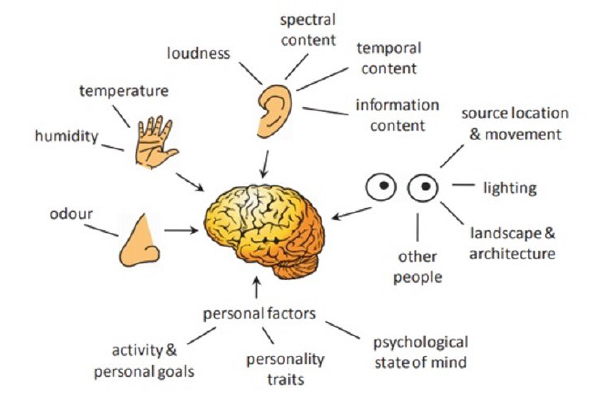
Figure 1: The Perceptual Organization of sound